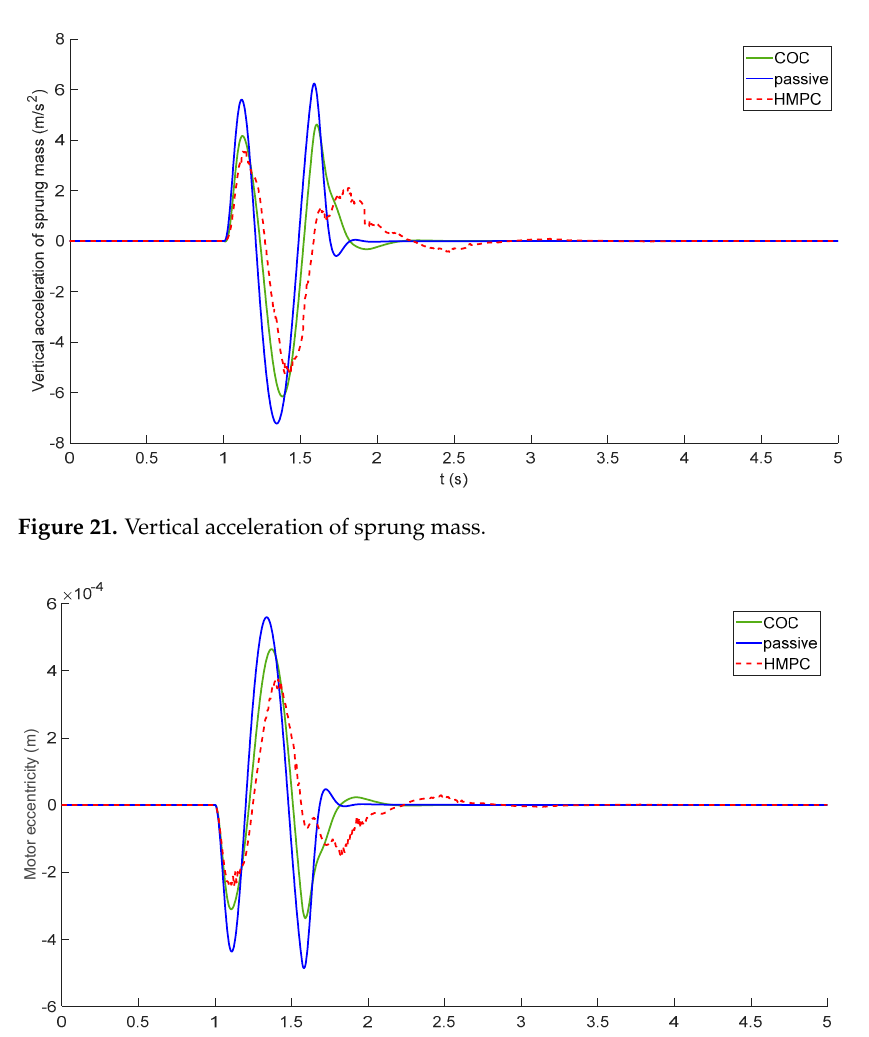
Figure 22. Motor